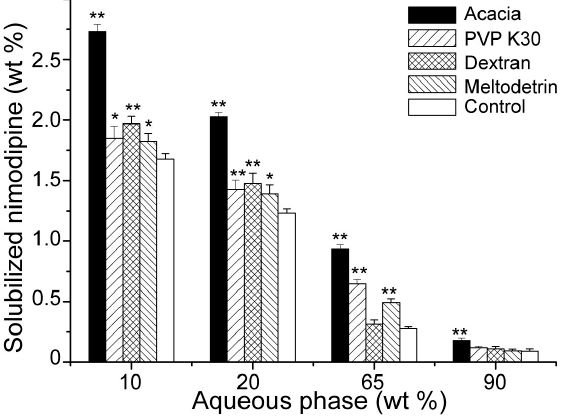
Figure 3. Effects of hydrophilic carriers on solubilization capacity of SMEDDS to nimodipine upon dilution with water. The control group was the SMEDDS without any carriers ( n = 3). * P < 0.05, ** P < 0.01 vs. control group.